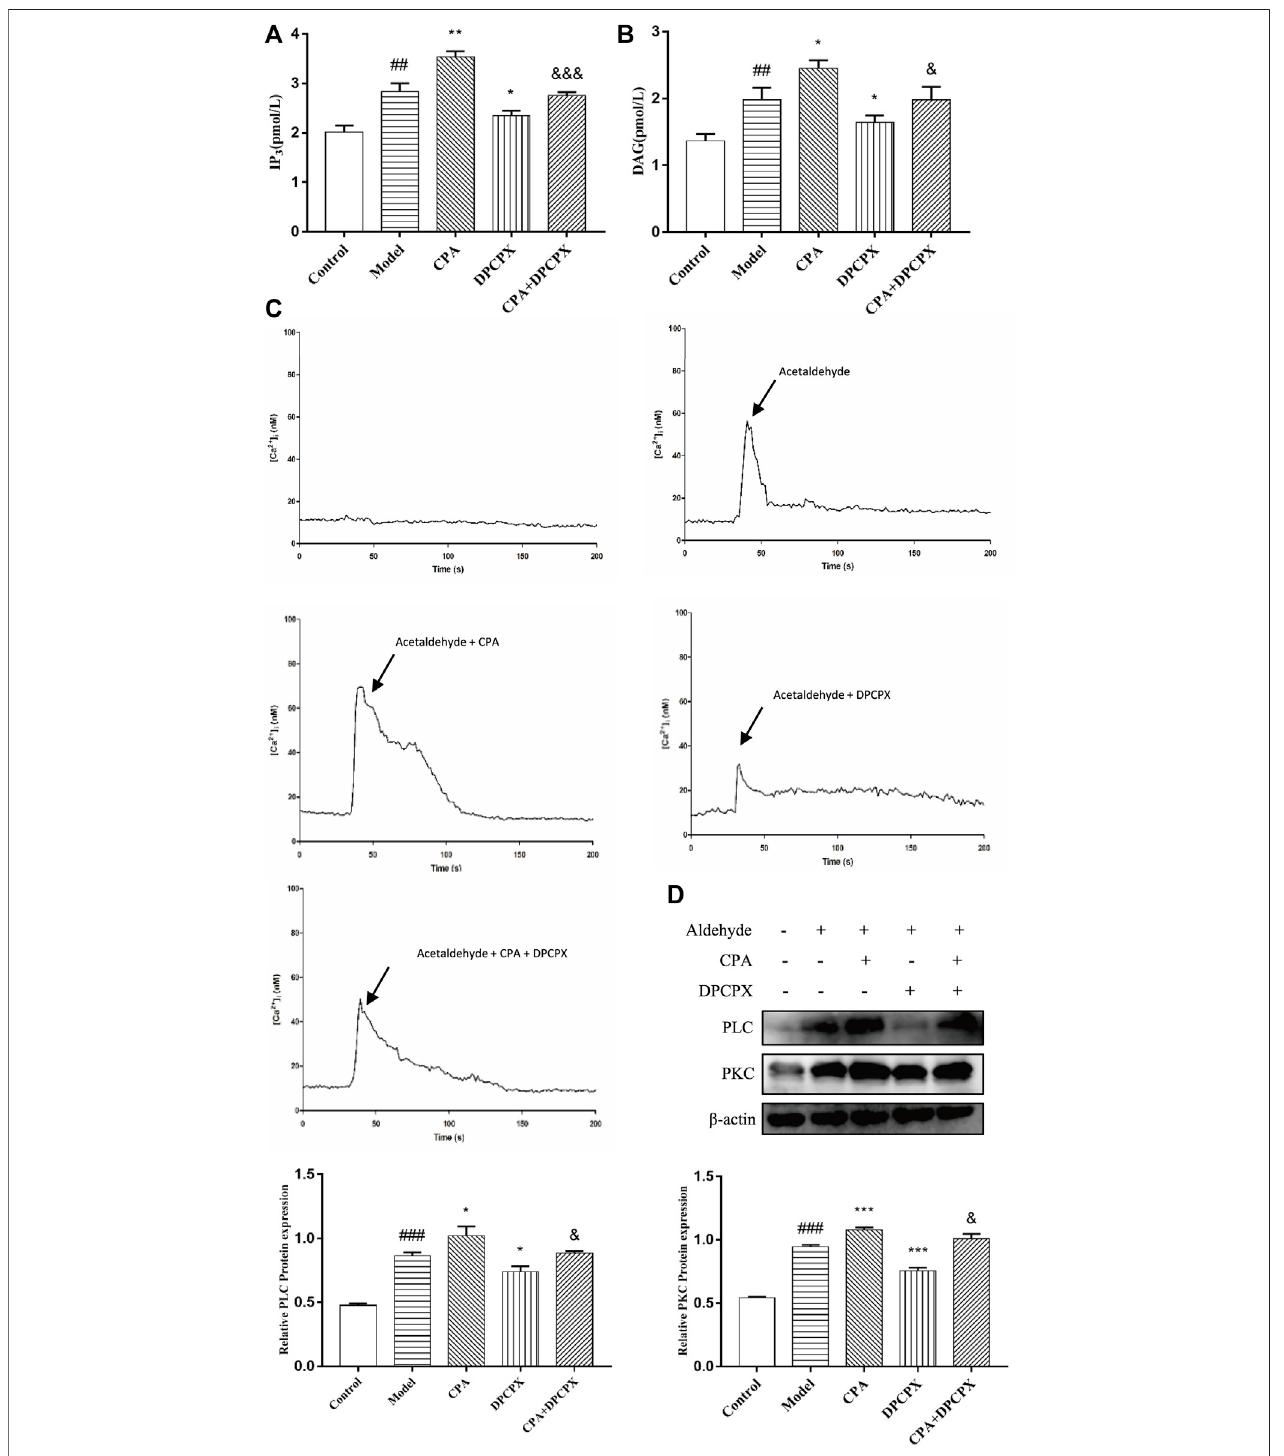
FIGURE 9 | A 1 R positively regulates PLC- IP 3 -Ca 2+ /DAG-PKC signaling pathway activity in acetaldehyde-induced HSC-T6 cell. (A) The content of IP 3 was assessed by ELISA. (B) The content of DAG was assessed by ELISA. (C) [Ca 2+ ] i concentration changes as visualized by Fluo-3-AM. (D) The protein levels of PLC and PKC in HSC-T6 cell. ## p < 0.01, ### p < 0.001 vs. the control group, *p < 0.05, **p < 0.01, ***p < 0.001 vs. the model group. & p < 0.05, &&& p < 0.001 vs. the CPA group.